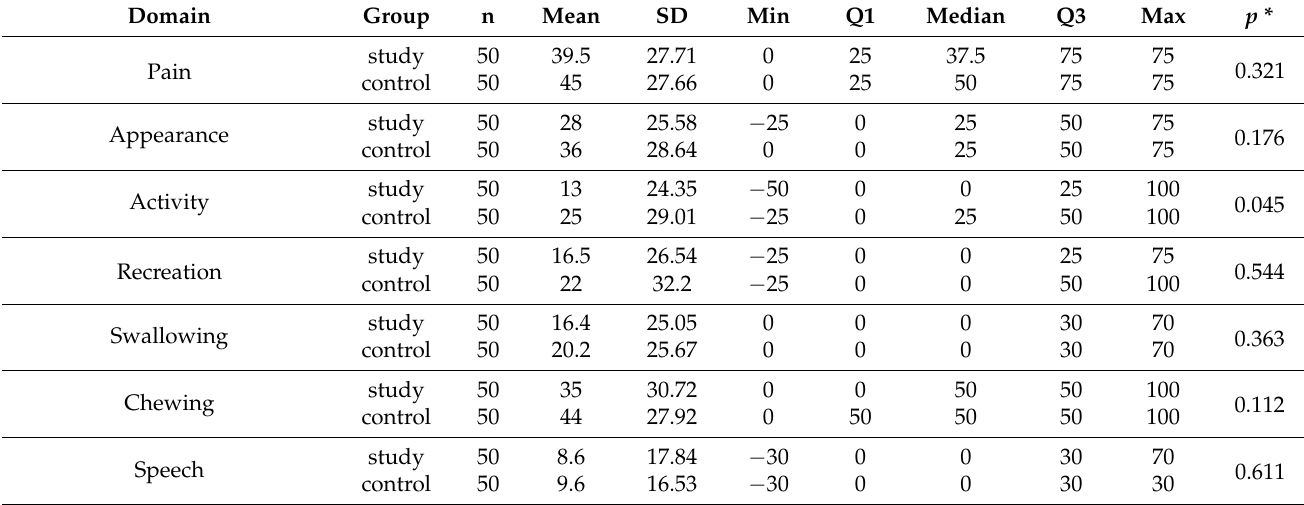
Table 7. Changes in QoL between 7th postoperative day and pre-operative